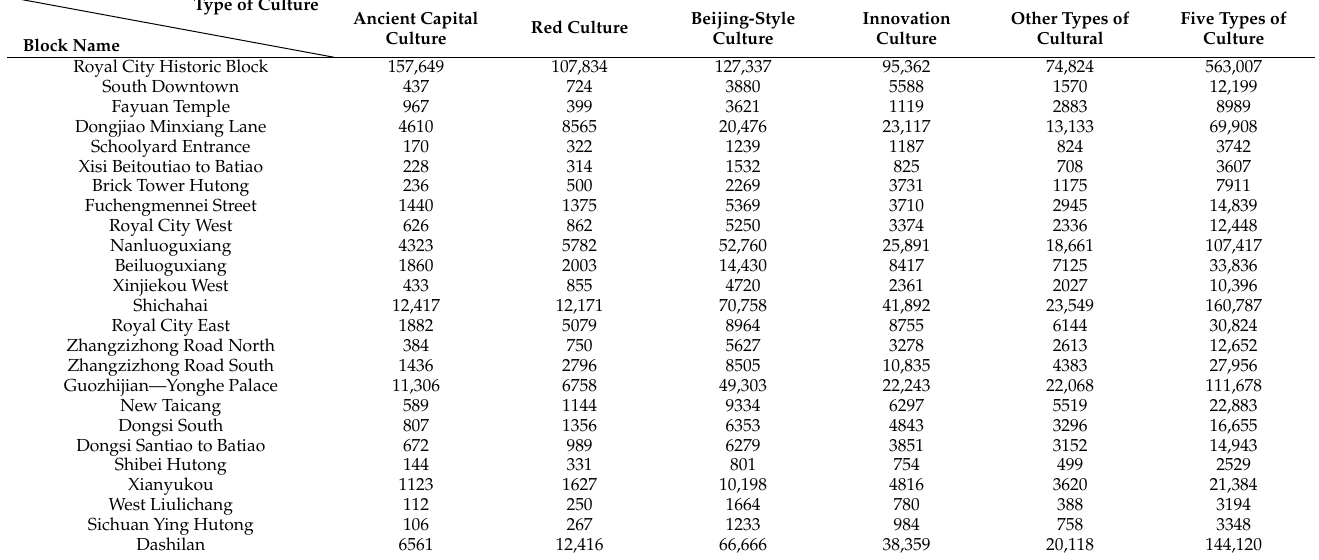
Table 2. Statistics on the number of cultures in the 28 historical and cultural blocks of Beijing’s old